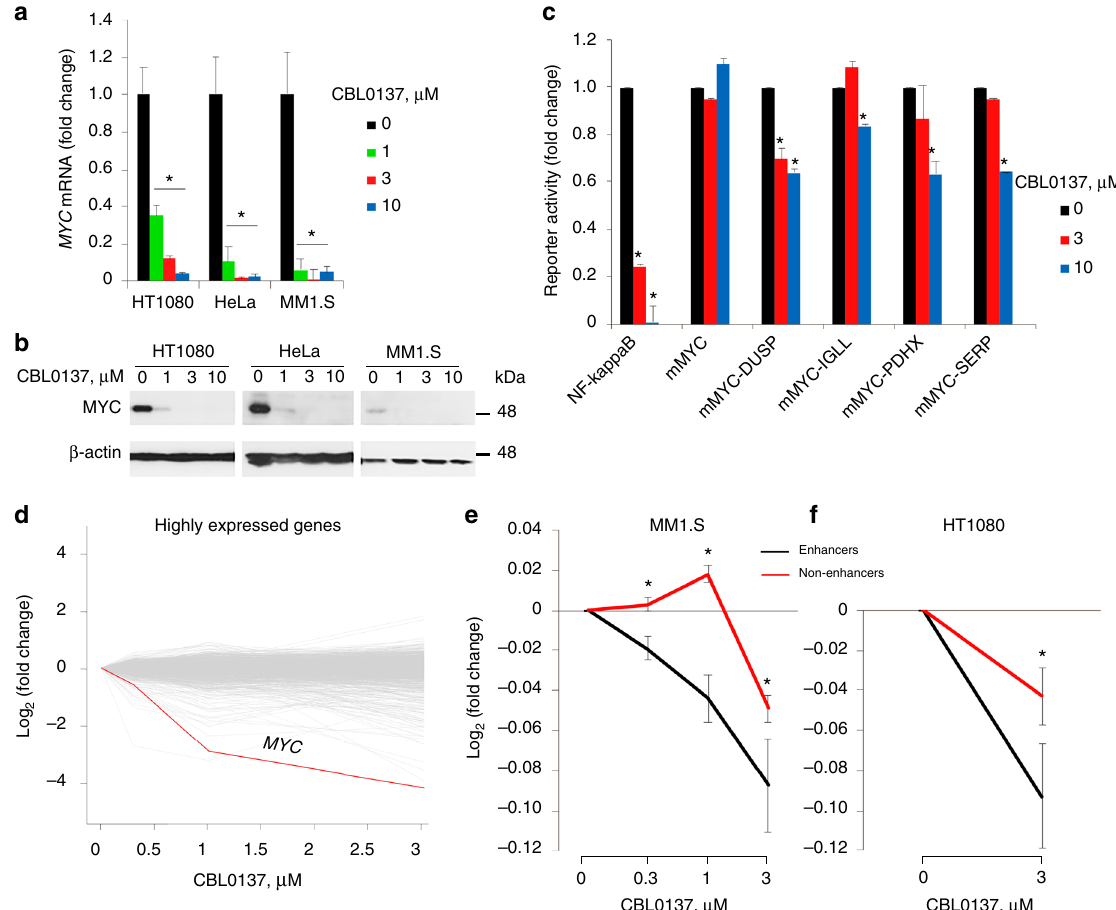
Fig. 1 Effect of curaxin CBL0137 on transcription in cells. a , b Reduction of MYC protein and mRNA levels in HT1080, HeLa, and MM1.S cells treated with different concentrations of CBL0137 for 6 h assessed by RT-qPCR ( a ) or immunoblotting ( b ). c Effect of CBL0137 treatment on the activity of reporter constructs transfected into MM1.S cells and regulated by the NF- κ B response element, minimal MYC promoter (m MYC ) and m MYC together with enhancer elements from the indicated genes (see Methods for details). d – f Effect of CBL0137 on the level of transcripts in MM1.S ( d , e ) and HT1080 ( f ) cells treated with different concentrations of CBL0137 for 6 h, assessed using microarray hybridization (MM1.S cells) or nascent RNA-seq (HT1080 cells). Error bars represent the s.e.m. for three replicates. For each group of genes, the mean log FCs and standard errors of gene expression after treatment are calculated. Source data of Fig. 1a – e are provided in a Source Data fi